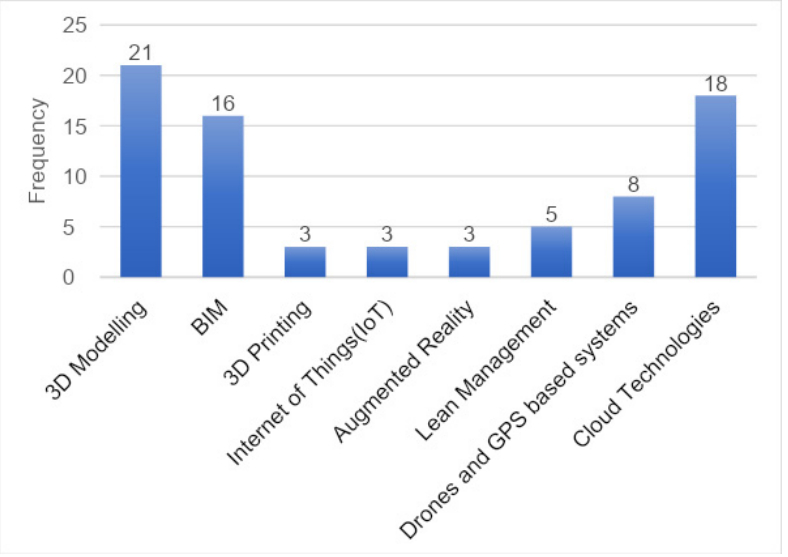
Figure 6. Responses to which of the following technologies sounds familiar.